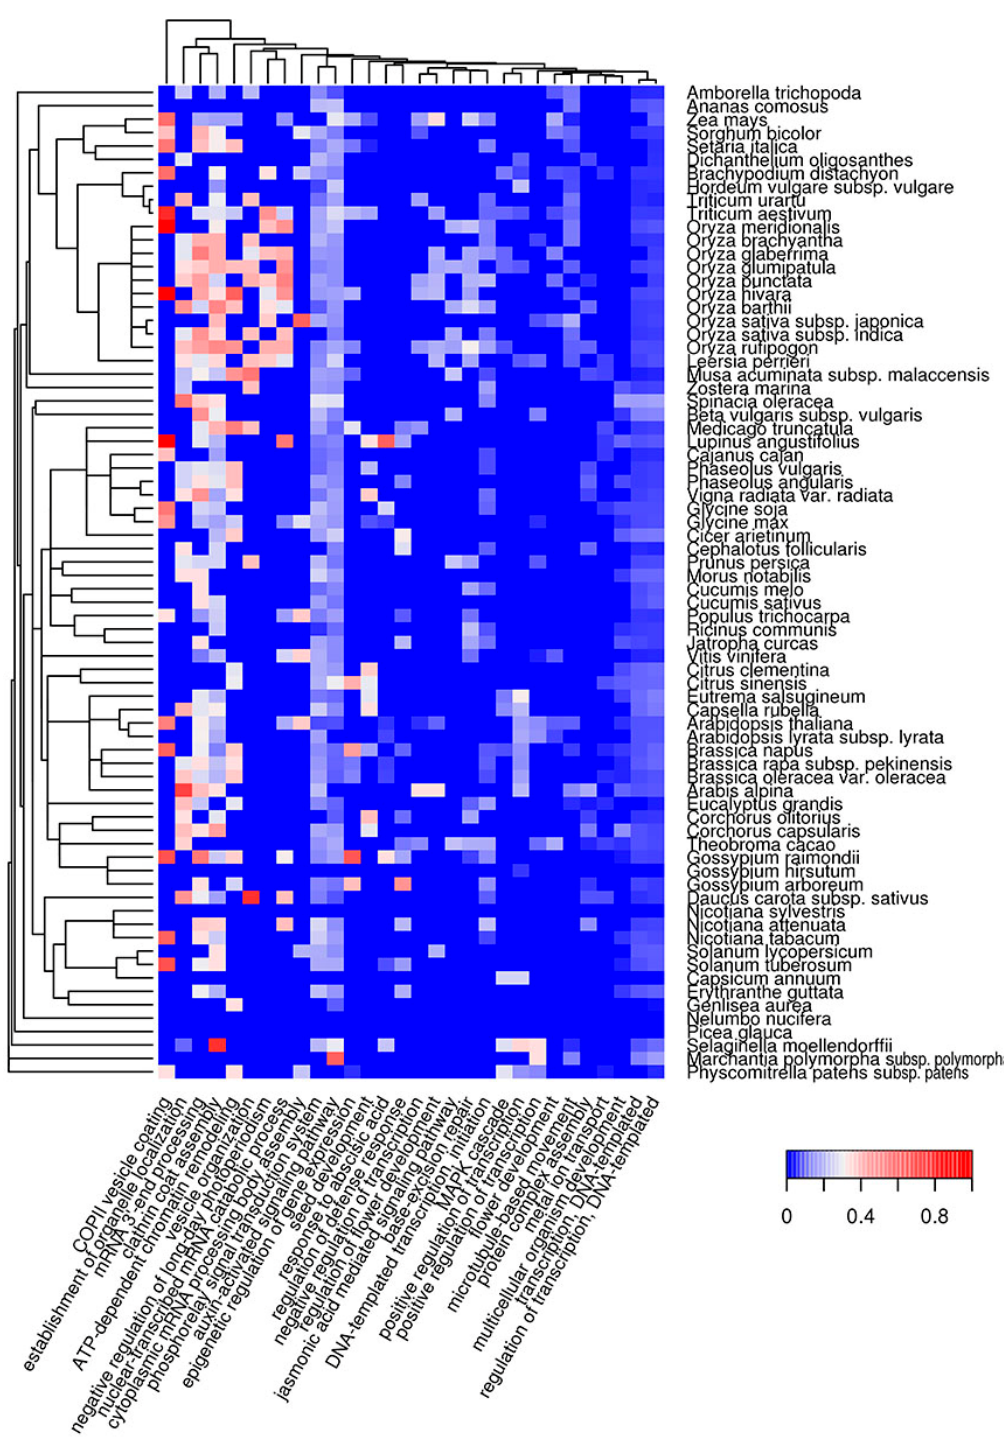
Figure 5. Heat map of GO biological processes in which QN-rich potentially amyloidogenic proteins predicted by SARP are overrepresented. For such proteins, the top 30 GO terms from the molecular function ontology are shown. The color of the cells denotes the fraction of QN-rich potentially amyloidogenic proteins predicted by SARP among all proteins annotated with this term. All cells with p -values greater than 0.01 have values of 0 ( dark blue ). The dendrogram of plant species corresponds to their phylogenetic tree.